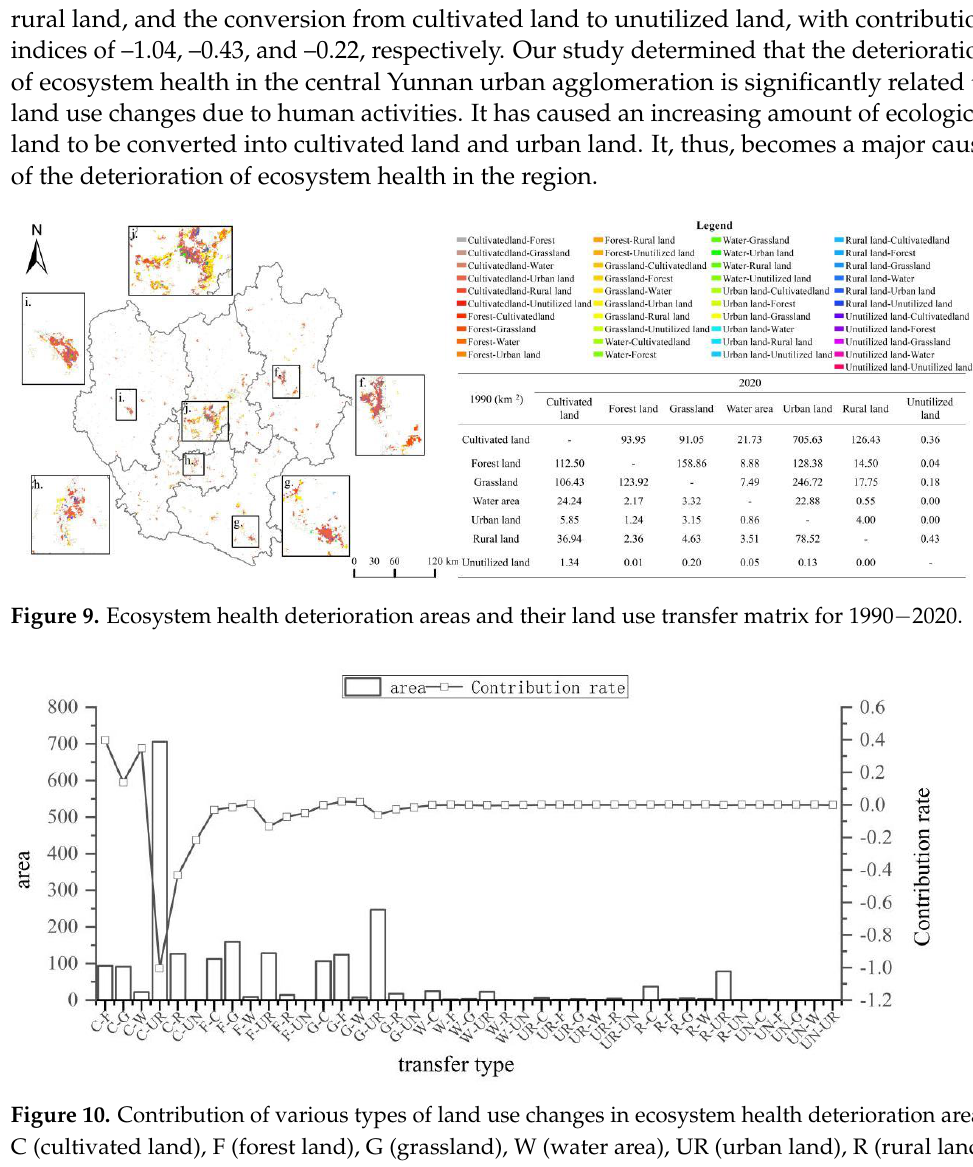
Figure 8. Contribution of various types of land use changes in ecosystem health improvement areas. C (cultivated land), F (forest land), G (grassland), W (water area), UR (urban land), R (rural land), UN (unutilized land).